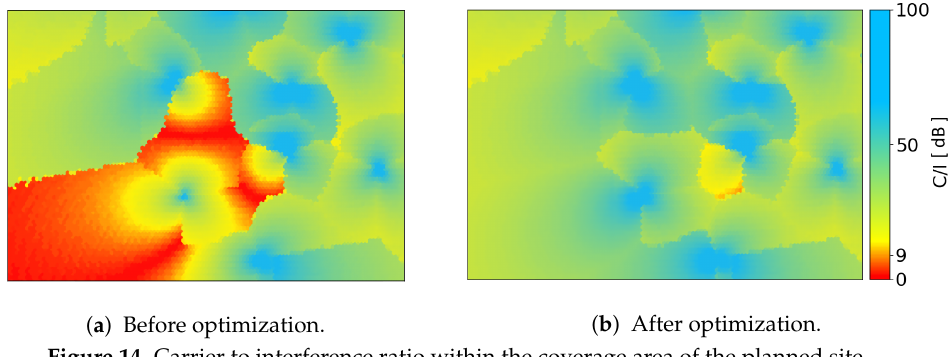
Figure 14. Carrier to interference ratio within the coverage area of the planned site.